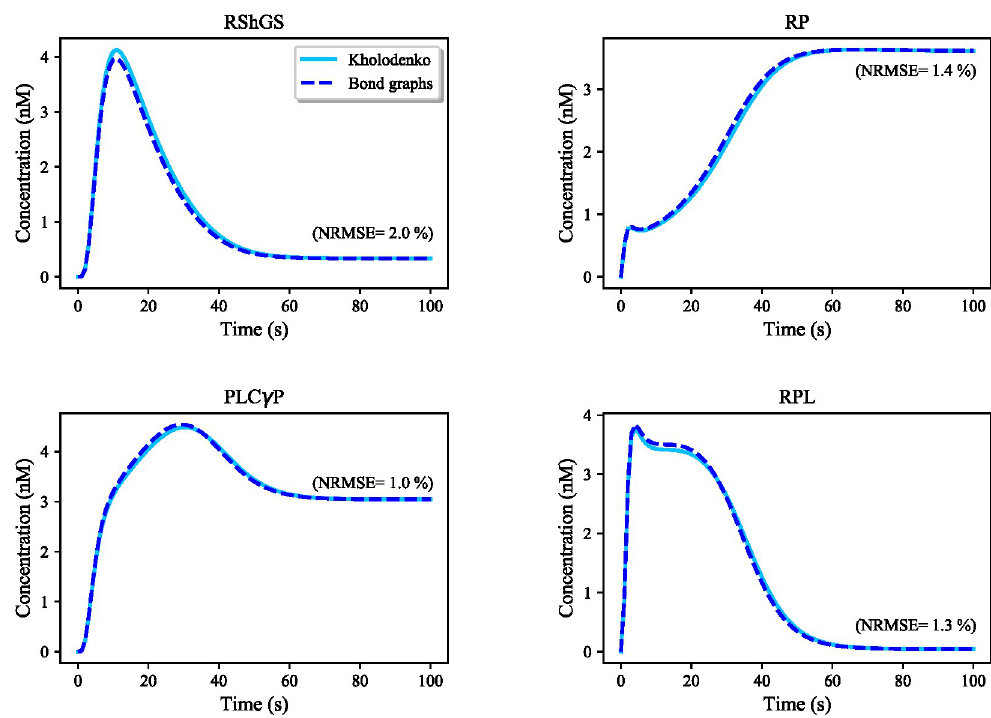
Fig 11. Comparison between the Kholodenko et al. EGFR model and its bond graph approximation. The simulations are given for four exemplar species in the pathway. NRMSE is calculated for each comparison in percentage. The initial concentration of EGF (the initiative molecule in the EGFR module) was 680